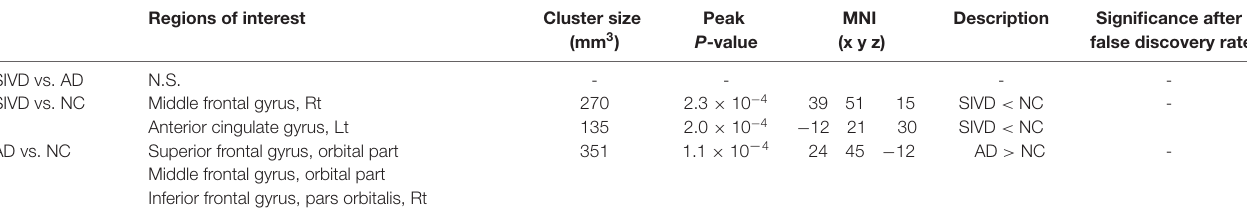
TABLE 3 | Major clusters showing significant differences in regional homogeneity among the subjects with SIVD, AD and NC in voxel-wise cluster analysis (100 mm 3 , p < 0.001 uncorrected). Regions of interest Cluster size Peak MNI Description Significance after (mm 3 ) P -value (x y z) false discovery rate SIVD vs. AD N.S. - - SIVD vs.